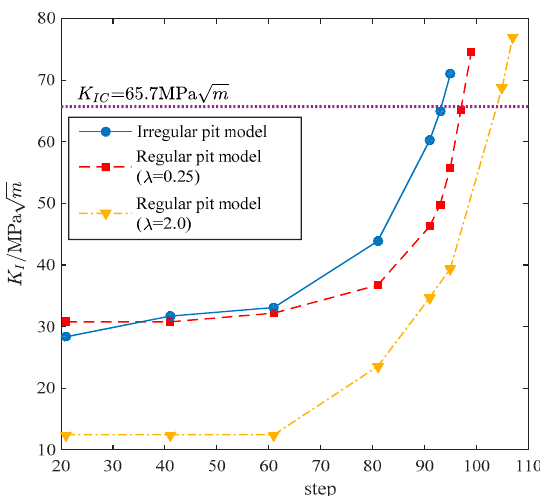
Figure16. Time-varyingcurvesofthestressintensityfactorforsteelwirewithdi ff erentpitmorphologies. Figure 16. Time-varying curves of the stress intensity factor for steel wire with different pit morphologies.